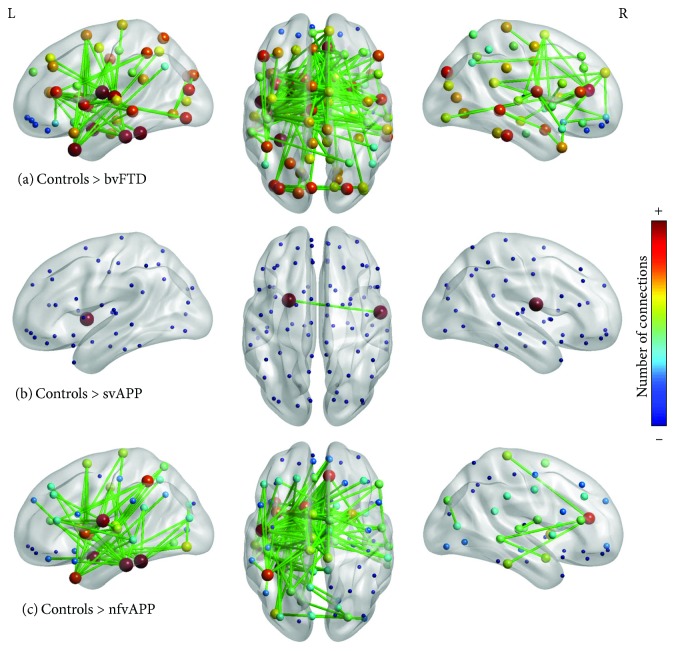
NBS results between controls and FTD variants. The edges are the result of F-test between groups. To nodes, the color corresponds to disconnection number.